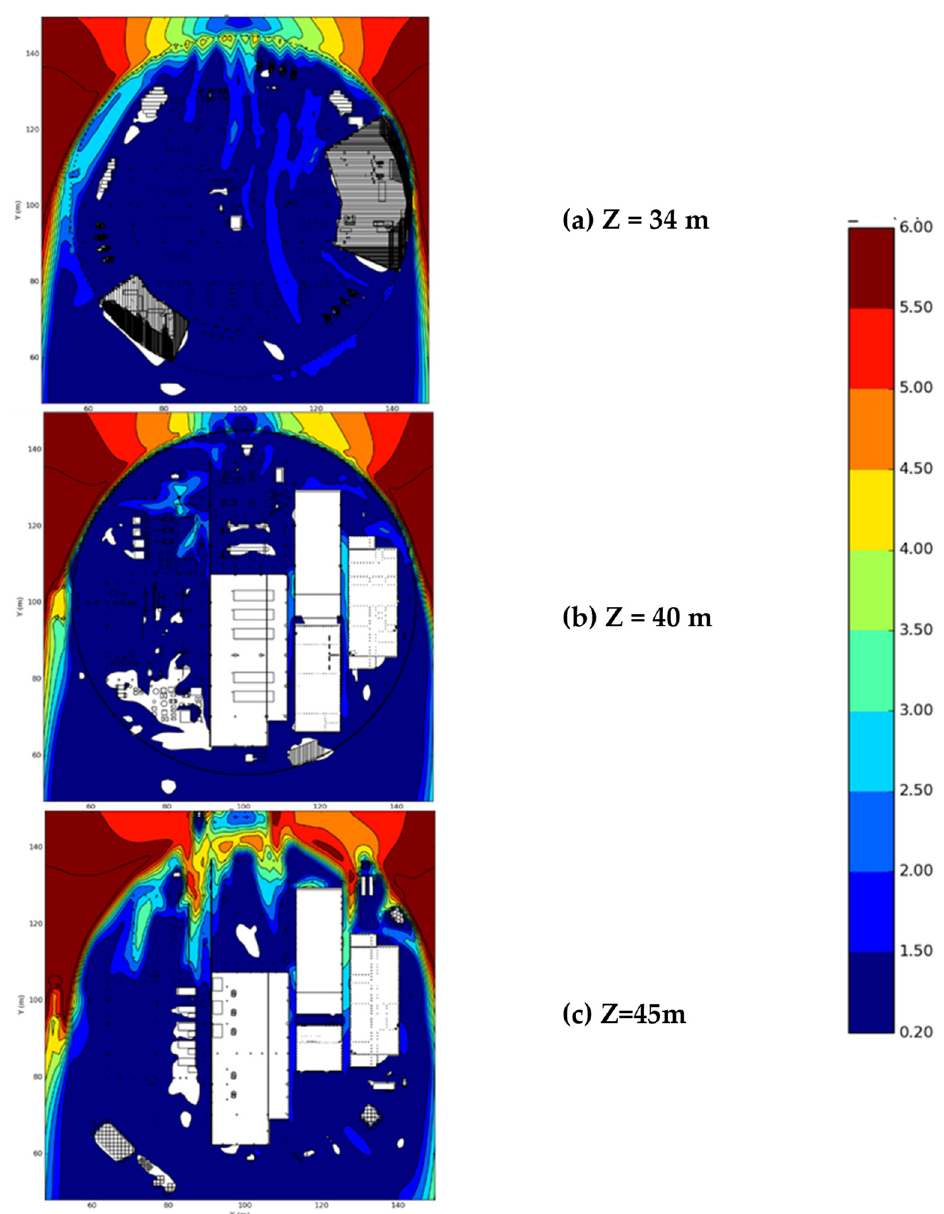
Figure 9. Wind velocity contour on LH11-1—Wind direction: N ( a ) main deck elevation, ( b ) process deck elevation, ( c ) above process deck (6 m).